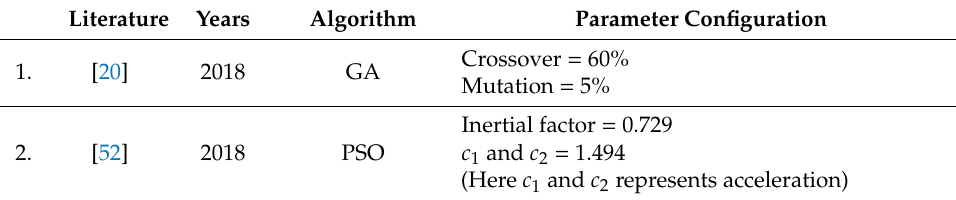
Figure 5. Description for case study 2.